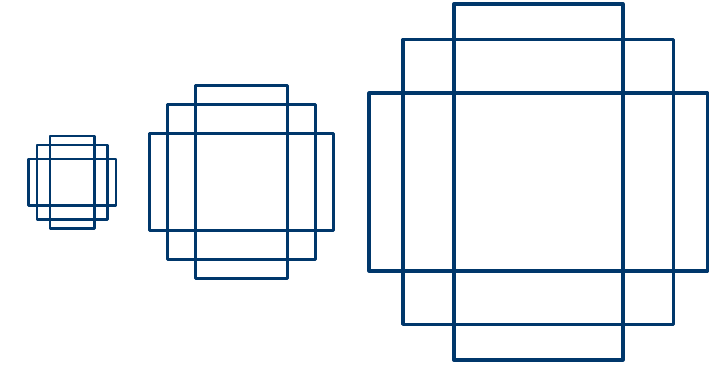
Figure 7. Anchor examples with nine different scales.